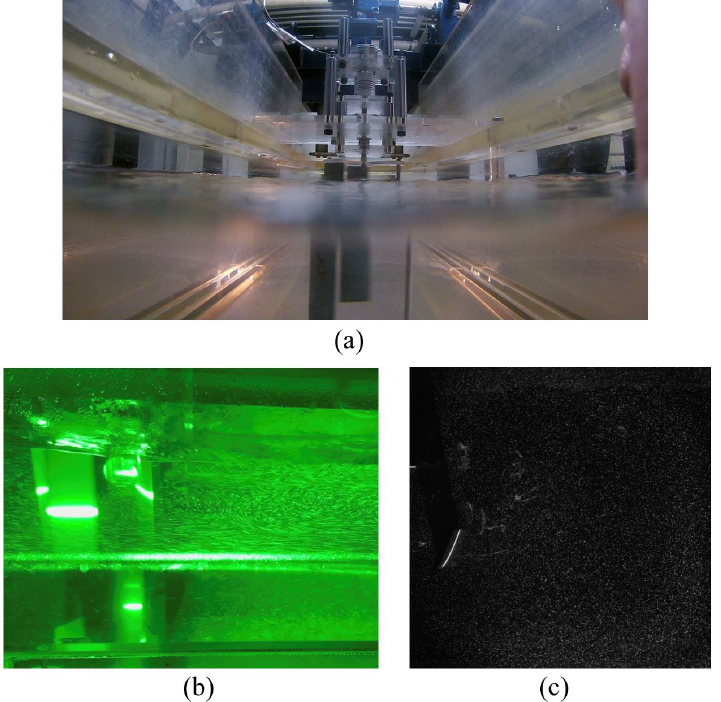
Figure 2. Pictures of the apparatus in action: a single turbine inside the water channel ( a ), a laser sheet illuminates seeding particles behind the turbine ( b ), and a raw PIV picture ( c